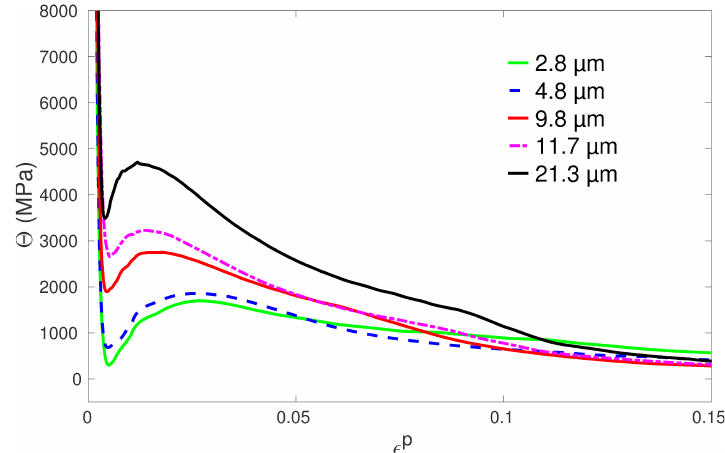
Figure 10. Model predictions for the work hardening rate evolution for the specimens of RR